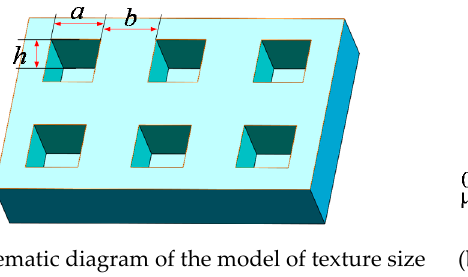
Figure 1. Schematic view of micro-textured surface, ( a ) Schematic diagram of the model of texture size; ( b ) Schematic diagram of the actual topographic map.